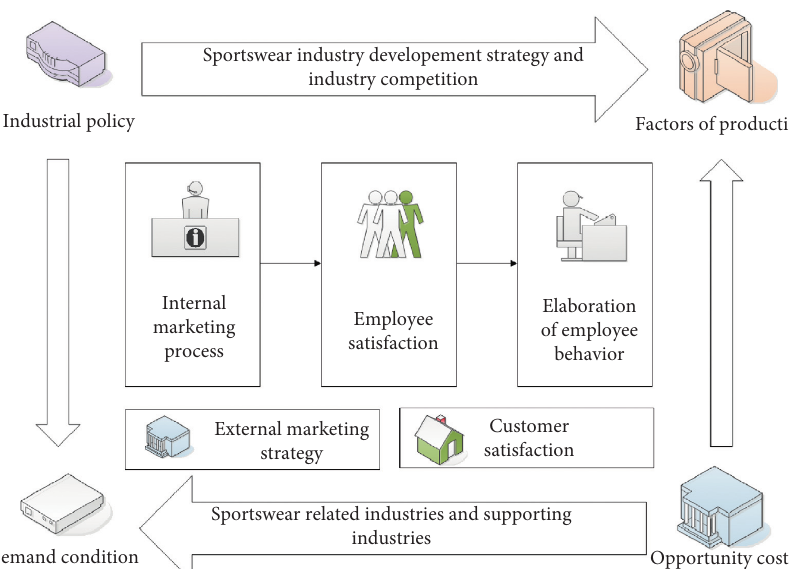
Figure 5: Internal marketing and integration model structure for external marketing.